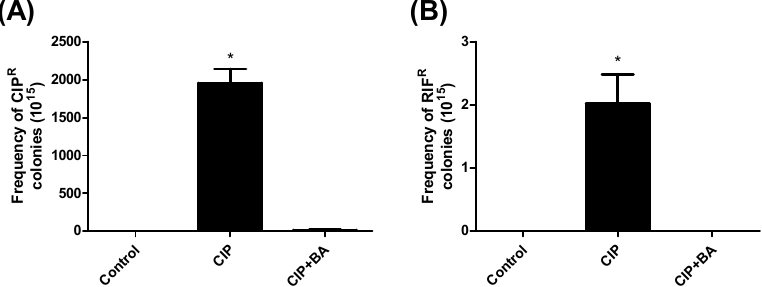
Figure 6. Effect of betulinic acid (200 µg/mL) in the reduction of mutation frequency induced by ciprofloxacin. S. aureus ATCC 6538 was incubated with ciprofloxacin (0.019 µg/mL) alone or in combination with betulinic acid (200 µg/mL). After 48 h, the mutants inside the bacterial population were selected using MH (Mueller–Hinton) agar, supplemented with ciprofloxacin or rifampicin. ( A ) Frequency of ciprofloxacin-resistant colonies (CIP R ) induced by ciprofloxacin; ( B ) Frequency of rifampicin-resistant (RIF R ) colonies induced by ciprofloxacin. BA—betulinic acid; CIP—ciprofloxacin; RIF—rifampicin. * indicates statistical differences related to the untreated cells ( p < 0.05).